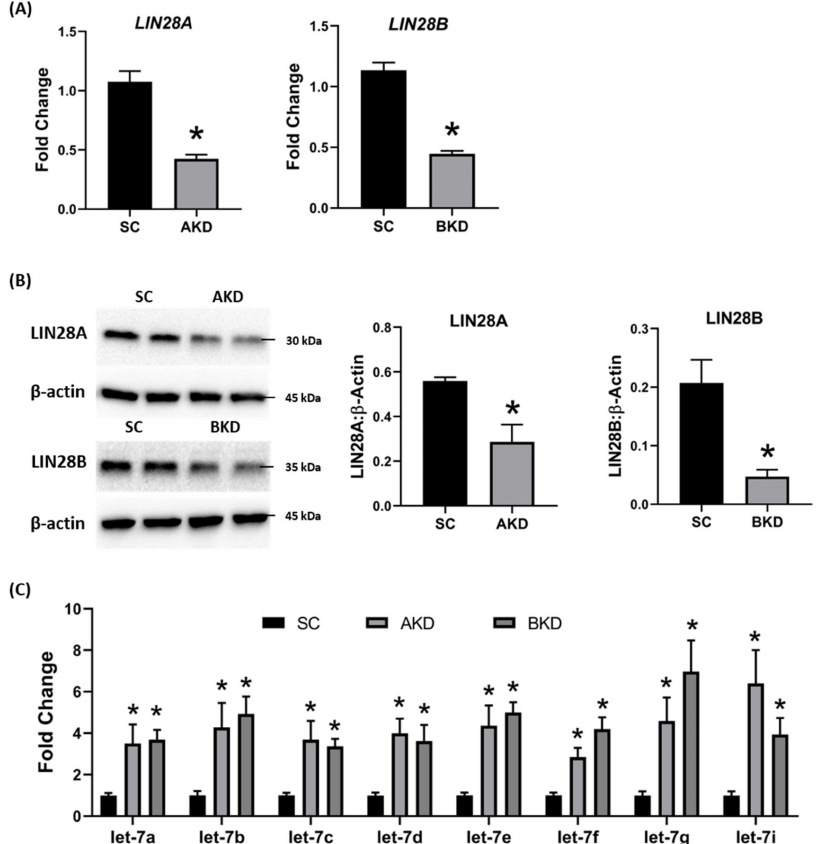
Figure 1. LIN28A or LIN28B knockdown and let-7 miRNAs in day 16 sheep TE. ( A ) LIN28A and LIN28B mRNA in AKD ( n = 5) and BKD ( n = 6) day 16 TE compared to SC ( n = 6). ( B ) Representative immunoblots for LIN28A, LIN28B, and β -actin in AKD, BKD, and SC day 16 TE, and densitometric analysis. ( C ) Let-7 miRNAs in AKD and BKD day 16 TE and SC. * p < 0.05 vs.